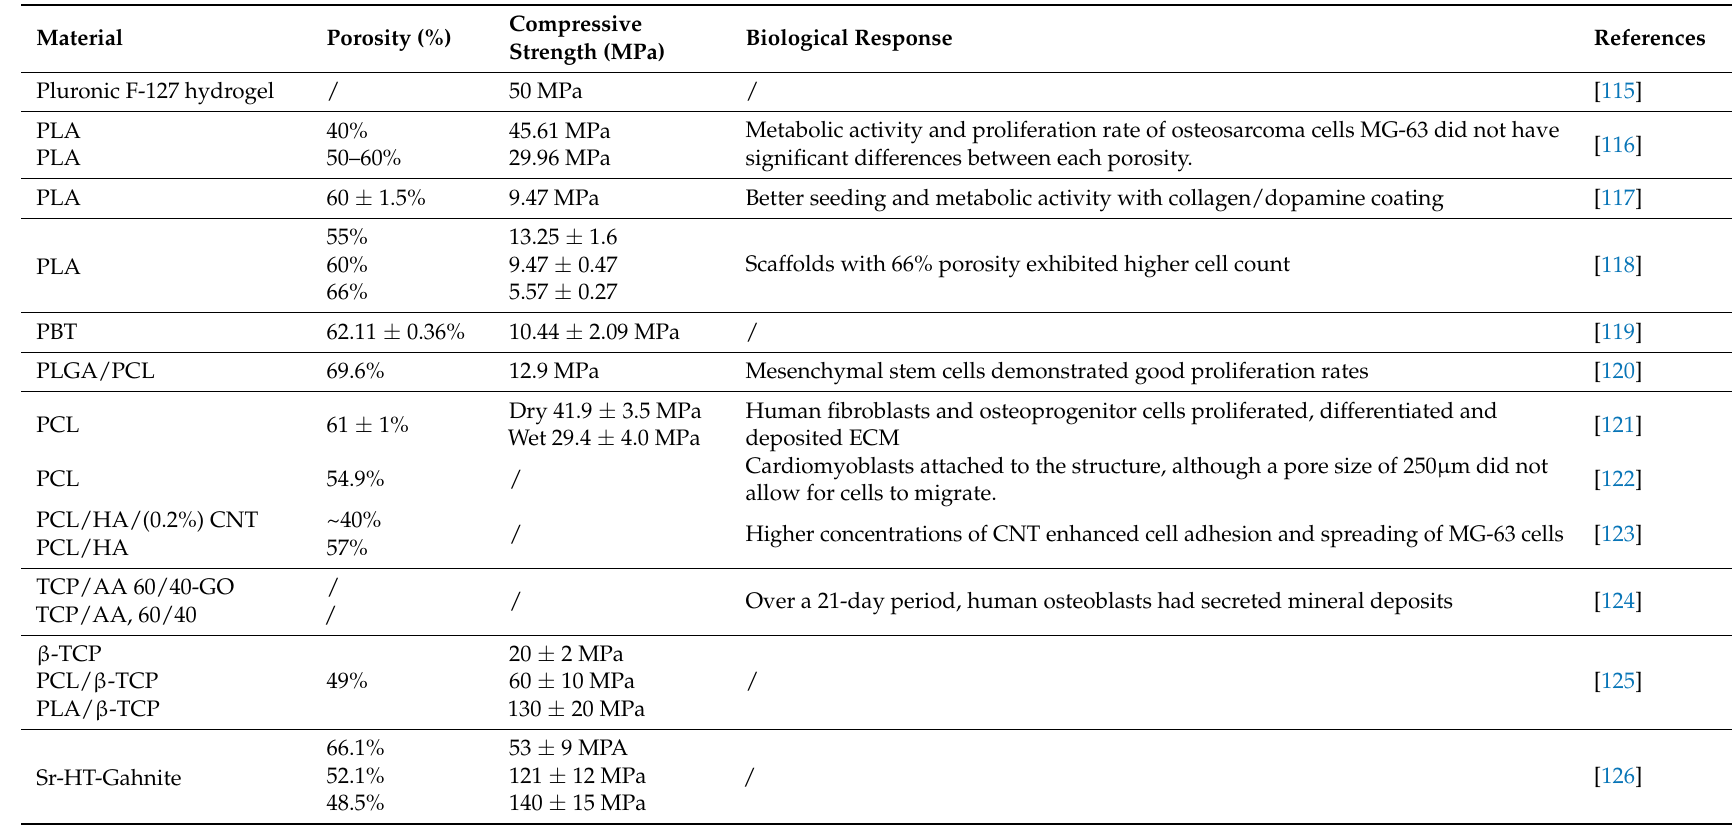
Table 4. Summary of Extrusion Printed Scaffold